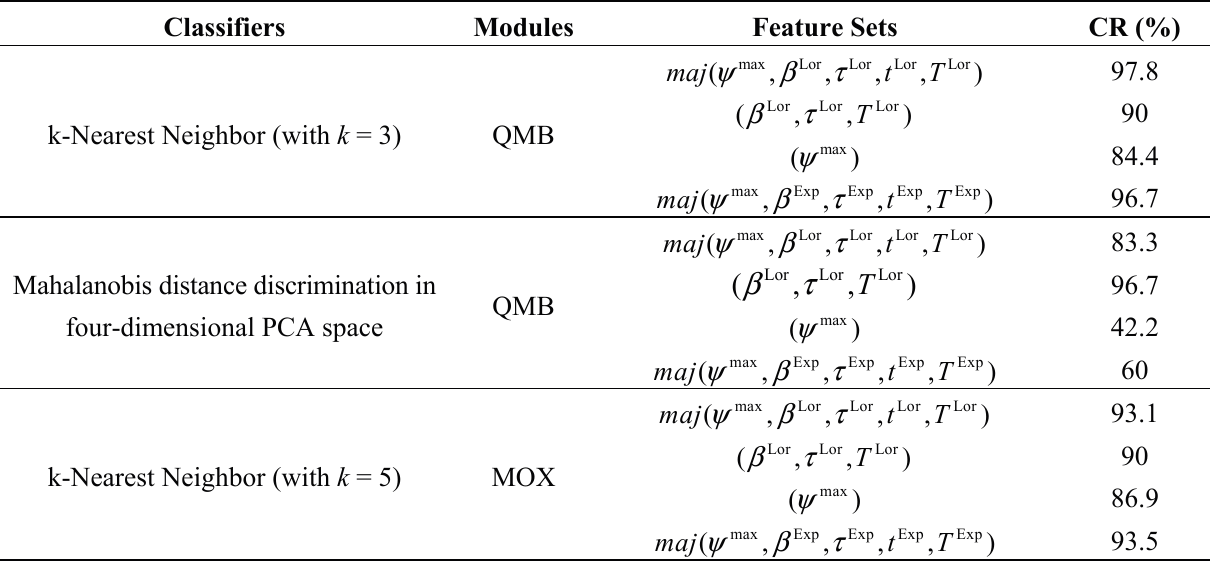
Table 8. Classification rates (CR) of different feature sets for QMB or MOX modules in [27].